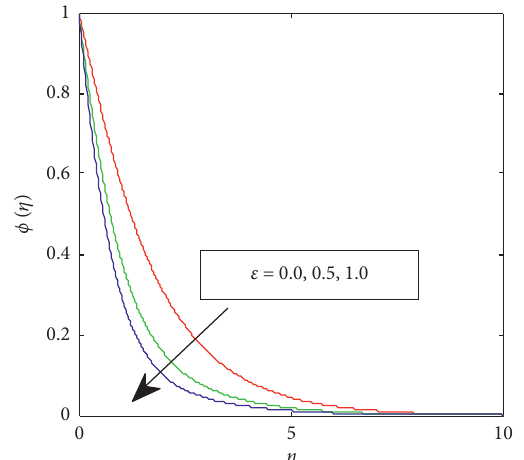
Figure 18: Concentration distribution for different values of chemical reaction parameters.